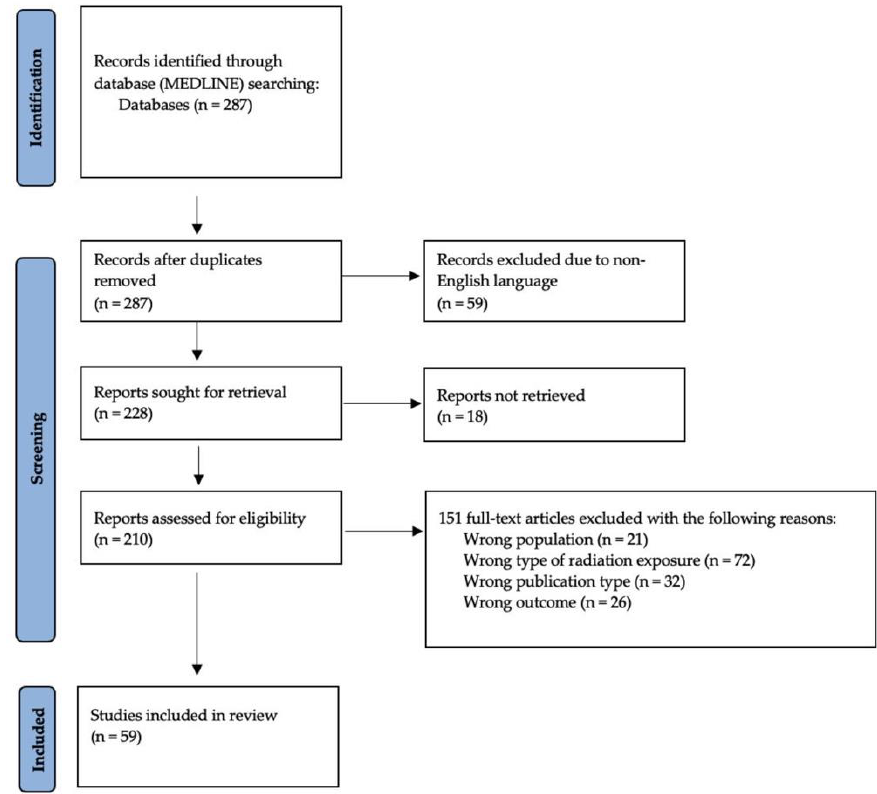
Figure 1. Flow diagram of article selection process, based on Page et al. (2020) [18].